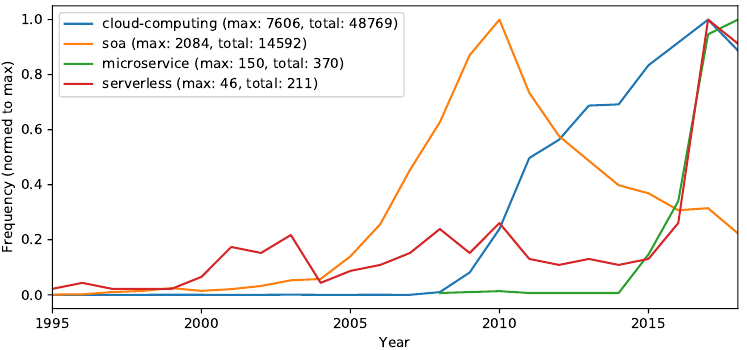
Figure 11. Trends of papers dealing with cloud-computing, SOA, microservices and serverless. Retrieved from Scopus (limited to computer science), 2018 extrapolated.